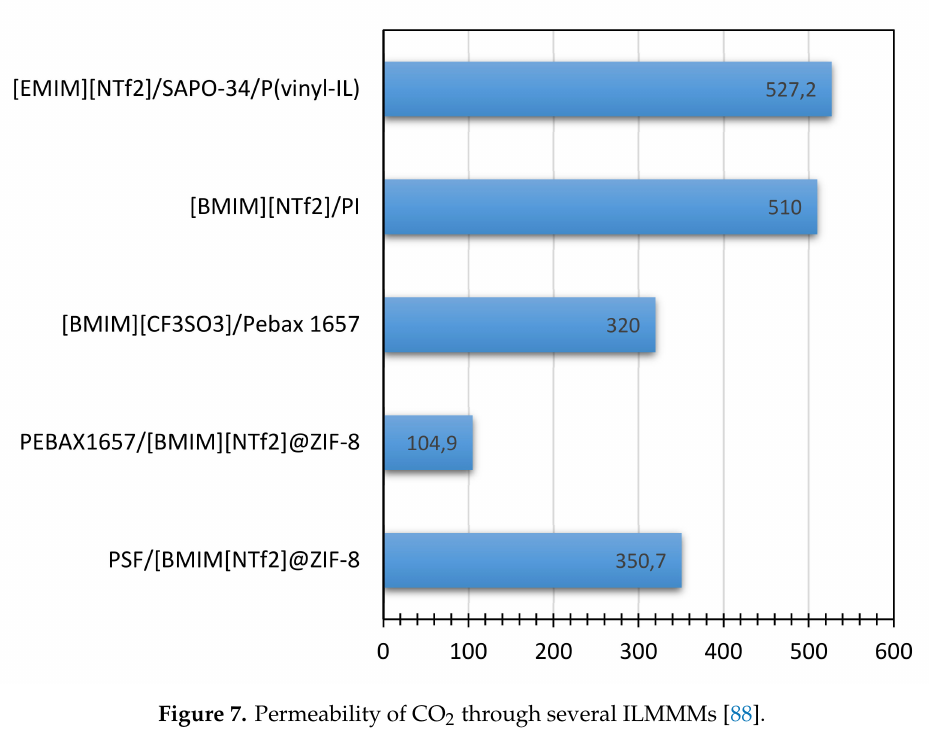
Figure 7. Permeability of CO 2 through several ILMMMs [88].